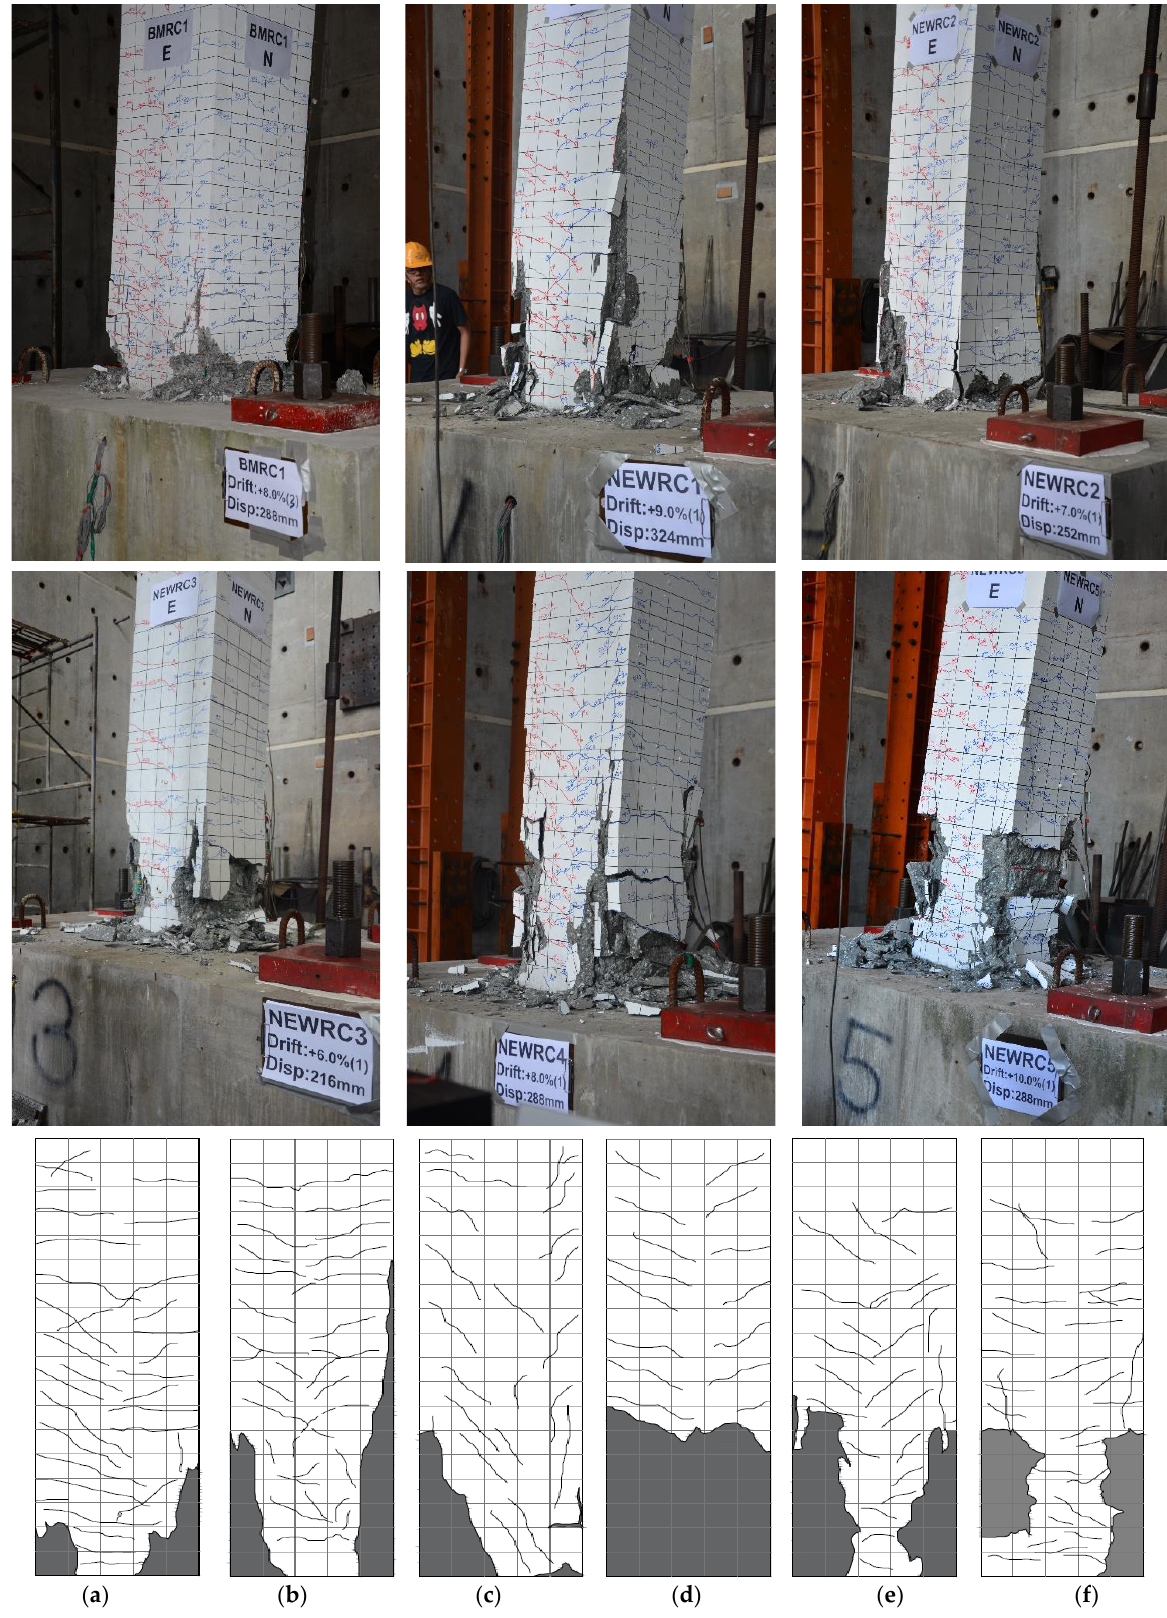
Figure 5. Crack pattern of damage at the end of the test: ( a ) BMRC1; ( b ) NEWRC1; ( c ) NEWRC2; ( d ) NEWRC3; ( e ) NEWRC4; ( f ) NEWRC5.